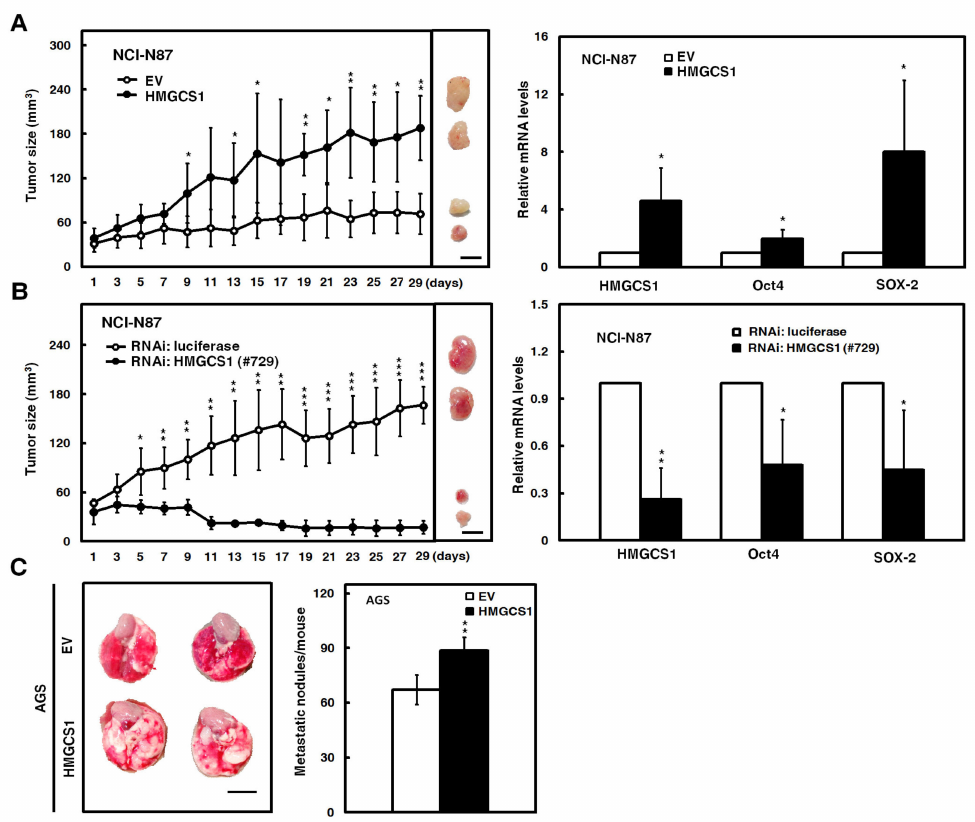
Figure 3. HMGCS1 enhances the tumor growth and lung metastasis of gastric cancer cells. ( A , B ) NCI-N87 cells were either transfected with the HMGCS1-expressing construct (HMGCS1) or empty vector (EV) ( A ) or infected with lentiviruses expressing siRNAs against HMGCS1 (#729) or luciferase ( B ). After treatment for 48 h, the treated cells were subcutaneously injected into nude mice ( n = 4 per group) for measurement of tumor sizes at the time indicated (left). Bar, 0.5 cm. The mice were sacrificed on day 29 and subcutaneous tumors were excised for the detection of HMGCS1, Oct4, and SOX-2 transcripts using quantitative real-time PCR (right). Mean ± SD. ( C ) AGS cells were transfected with the HMGCS1-expressing construct or empty vector for 48 h and then injected into nonobese diabetic severe-combined immunodeficiency (NOD-SCID) mice ( n = 4 per group) by tail vein injection for measurement of metastatic nodules in lungs. After 13 weeks, the mice were sacrificed and the metastatic nodules in lungs of the treated mice were also counted by gross and microscopic examination. Mean ± SD. *, p < 0.05; **, p < 0.01; ***, p <